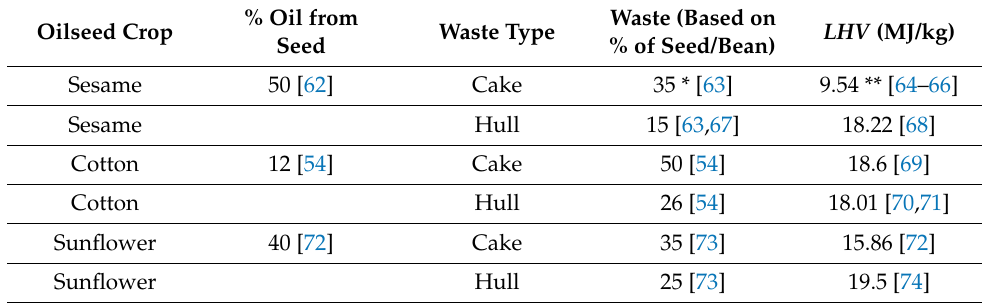
Table 4. Oilseed crop residue data. Oilseed Crop